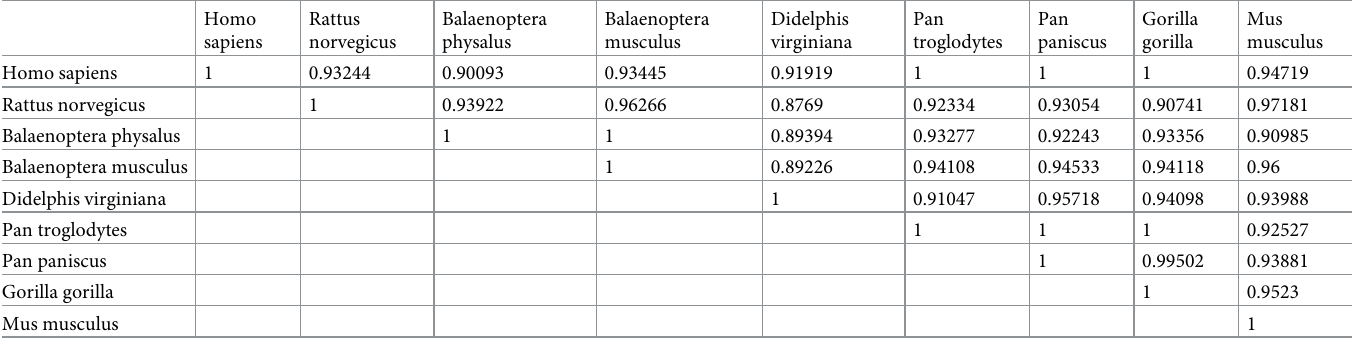
Table 14. The parameter Test’s Accuracy (F-Score) of the HELIOS method with referencing the Smith-Waterman algorithm in the accuracy measurement of classi- fication output. The assumed dataset is the “Nine ND5 protein sequences dataset” [53] in this study. Homo